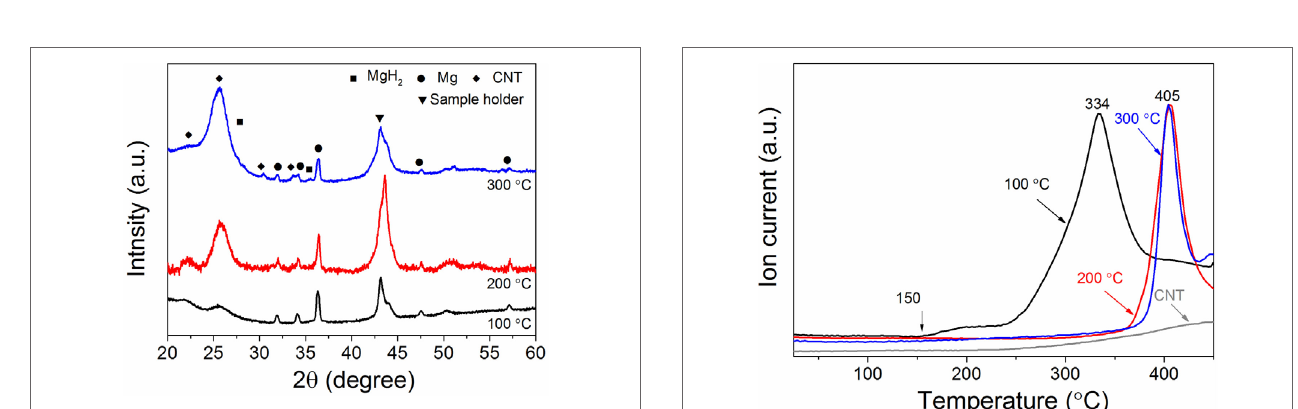
FigUre 2 | (a,B) Bright field of transmission electron microscopy (TEM) images of pristine carbon nanotubes (CNTs), (c) Bright field and (D) dark field TEM image of magnesium (Mg) deposited at CNTs with a concentration of 1 mg ml –1 , (e,F) Bright field and (g) dark field TEM image of Mg deposited at CNTs with a concentration of 2 mg ml –1 , (h) associated selected area electron diffraction (SAED) pattern of a dispersion of CNTs; (i) Bright field and (J) dark field TEM image of Mg deposited at CNTs with a concentration of 5 mg ml –1 ; (K) Bright field and (l) dark field TEM image of Mg deposited at CNTs with a concentration of 10 mg ml –1